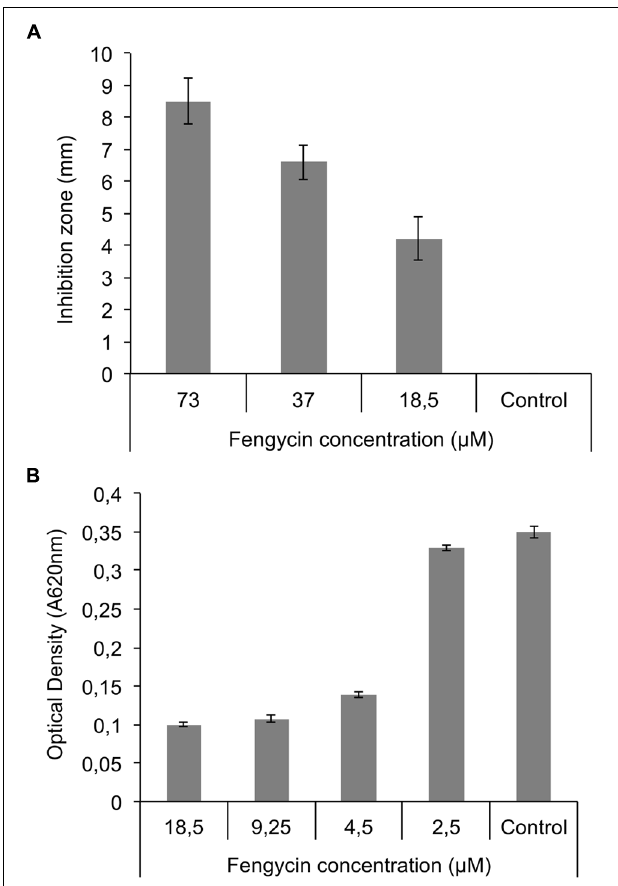
FIGURE 6 | Fengycin effect on mycelial growth and sporulation of R. variabilis . (A) Effect of pure fengycins on R. variabilis growth on PDA plates after 48 h at 25 ◦ C in a well-diffusion assay. All tested concentration were able to inhibit growth of fungal mycelium. (B) Effect of pure fengycin on sporulation of R. variabilis grown in 96-well microplates. Fungal growth was evaluated by measuring OD at 620 nm in presence of different concentrations of fengycins. 4.5 µ M is the minimal inhibitory concentration (MIC) capable of inhibiting the growth of the pathogen. Pure fengycins (purity > 99%) were diluted in 50% methanol. Control: 50% methanol. Data are from three independent